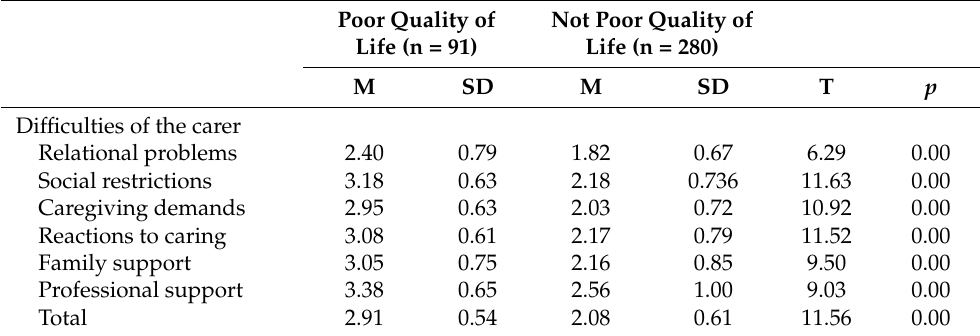
Table 9. Results of the study of the difficulties of the caregiver as a function of the perception of quality of life.